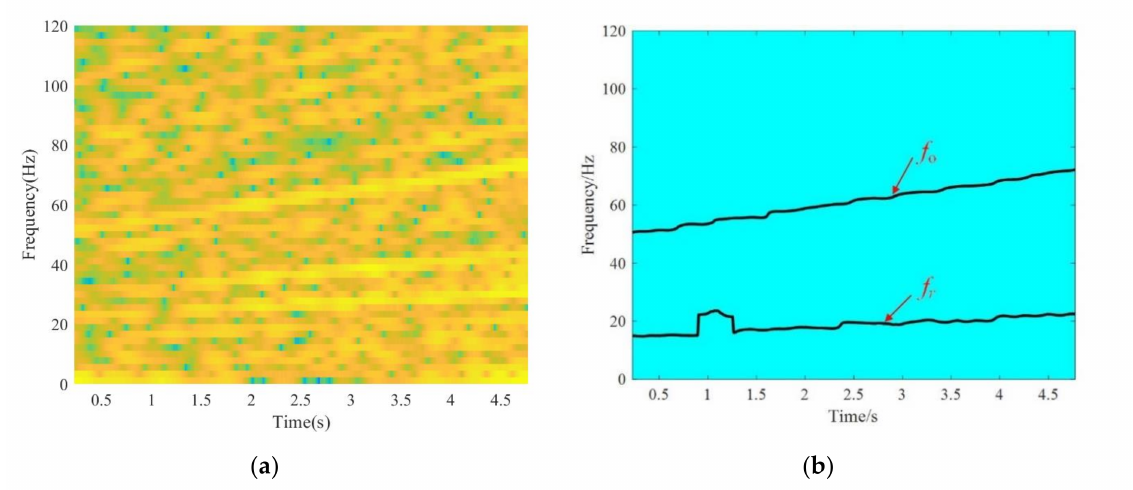
Figure 20. TFR of bearing outer race fault signal generated by di ff erent methods. ( a ) TFR generated by STFT. ( b ) the result provided by proposed